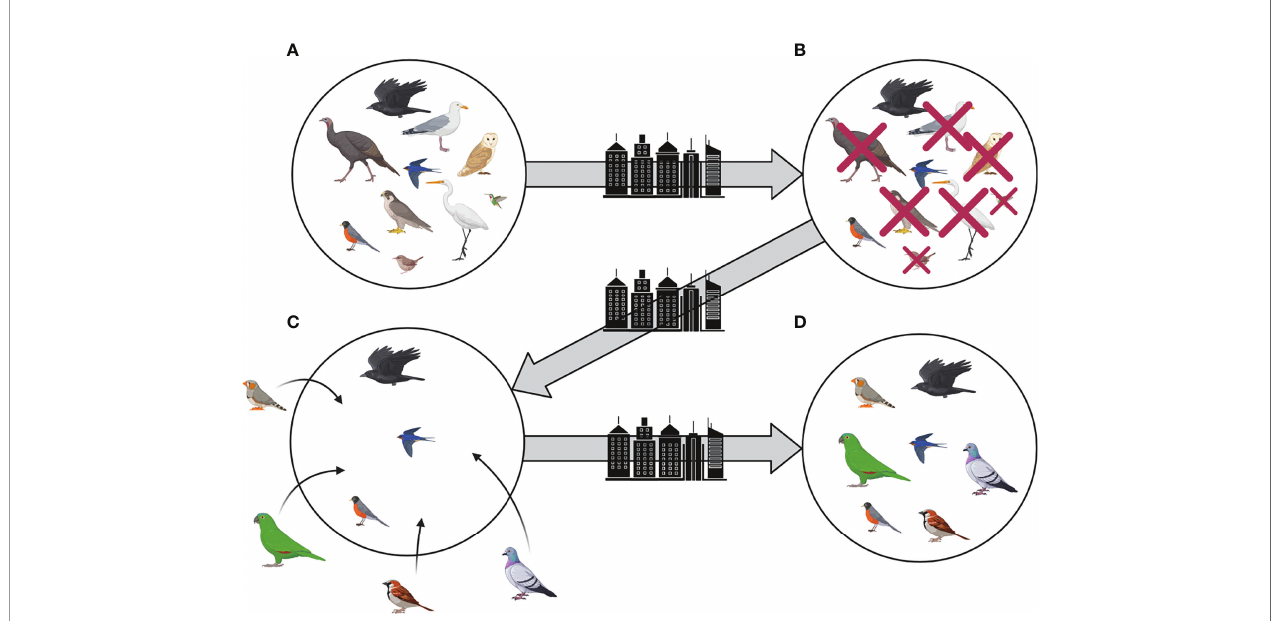
FIGURE 2 | Species loss, replacement, and subsequent shifts in community composition during the chronic disturbance of urbanization, as illustrated by an avian community. The original pre-disturbance community is represented by (A) , while a stable post-disturbance community is represented by (D) where the community is more functionally similar than the original state (e.g., predominantly omnivorous species) and non-native species predominate (e.g., house sparrow, rock pigeon, and monk parakeet in the United States). Transitional stages of avian community composition are represented by (B, C) , which demonstrate species loss and replacement, respectively, through the process of niche fi ltering (Created with